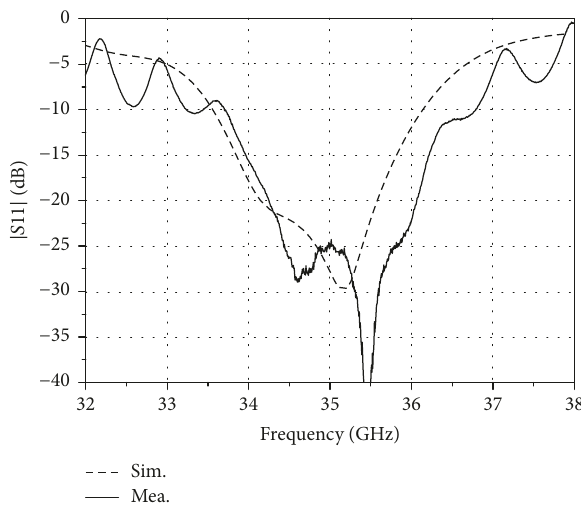
Figure9:Simulatedandmeasuredreturnlossof2 × 8antennaarray.